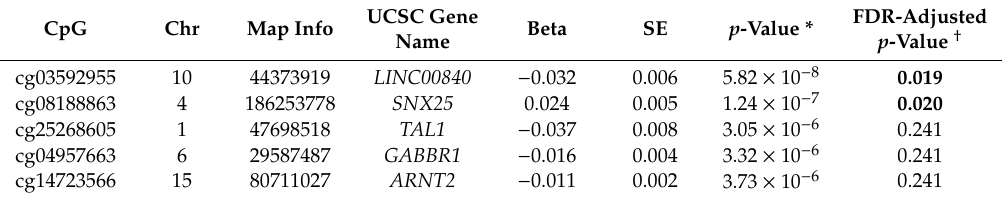
Table 2. Association between the DNAm of the top five CpG sites with breastfeeding duration > 6 months at 10